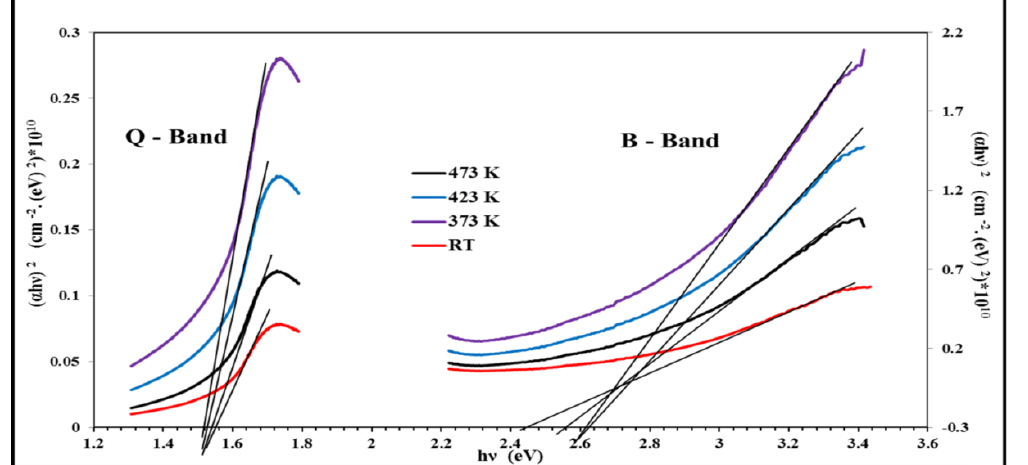
Fig. 6: (αhv) 2 versus hv for the blend CuPcTs/PEDOT PSS thin films at different annealing temperatures for Q and B